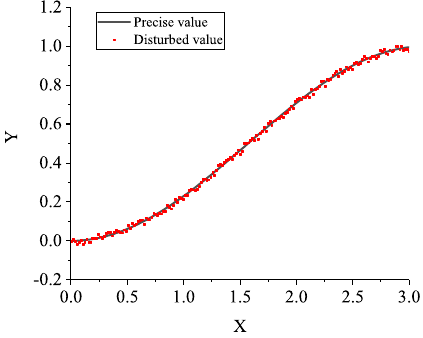
Figure A1. Solid line: y 1 = 0.5 × ( 1 − cos ( x ) ) , Dot line: y = y 1 + 0.04 ∗ random ( − 1,1 ) .